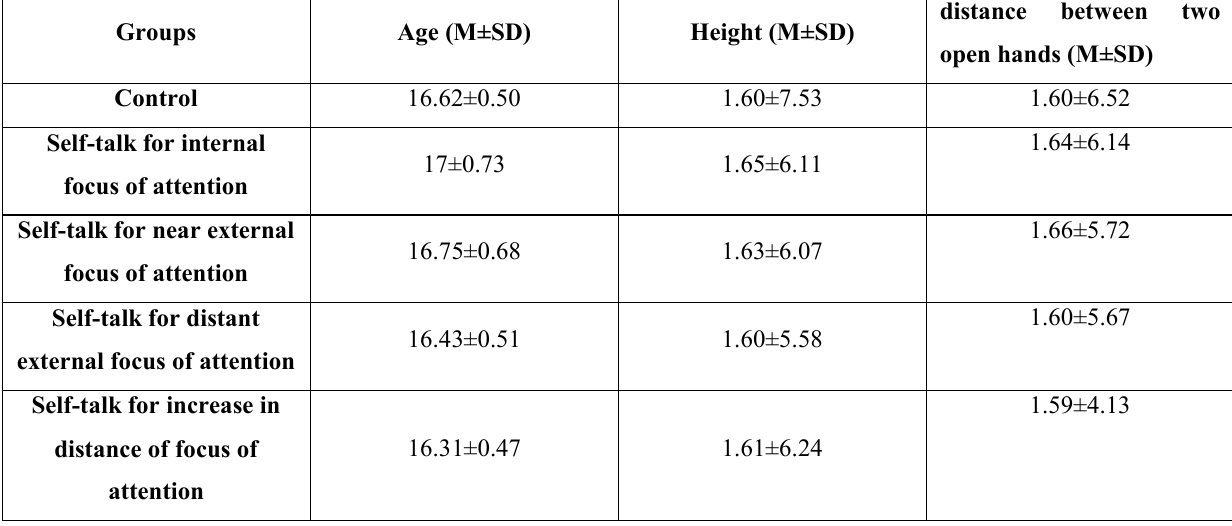
Distribution of Frequency & Characteristics of Participants